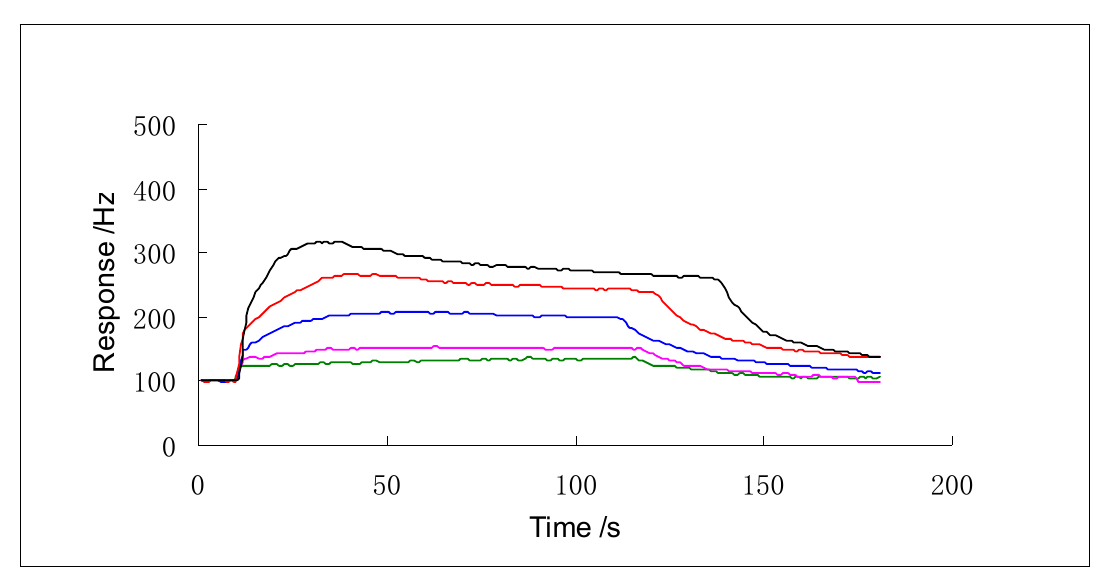
Figure 4. The response curves to 1, 2, 4, 6 and 10 ppm DMMP (from bottom to